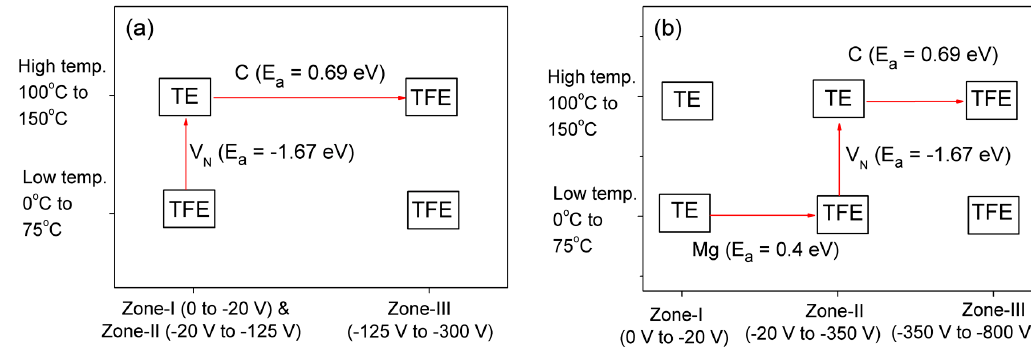
Figure 13. Change of CM with voltage zones and temperature ranges in SBDs with ( a ) 15 µ m DL and ( b ) 30 µ m DL. Adapted from [58] A. Sandupatla et al. 2020 Appl. Phys. Exp. https: // doi.org / 10.35848 / 1882-0786 / ab93a0. Copyright [2020] by Japanese Society of Applied Physics.